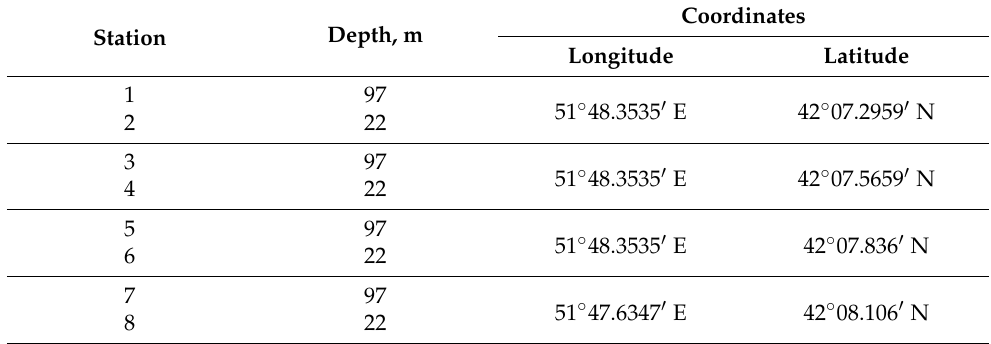
Table 1. The station coordinates and